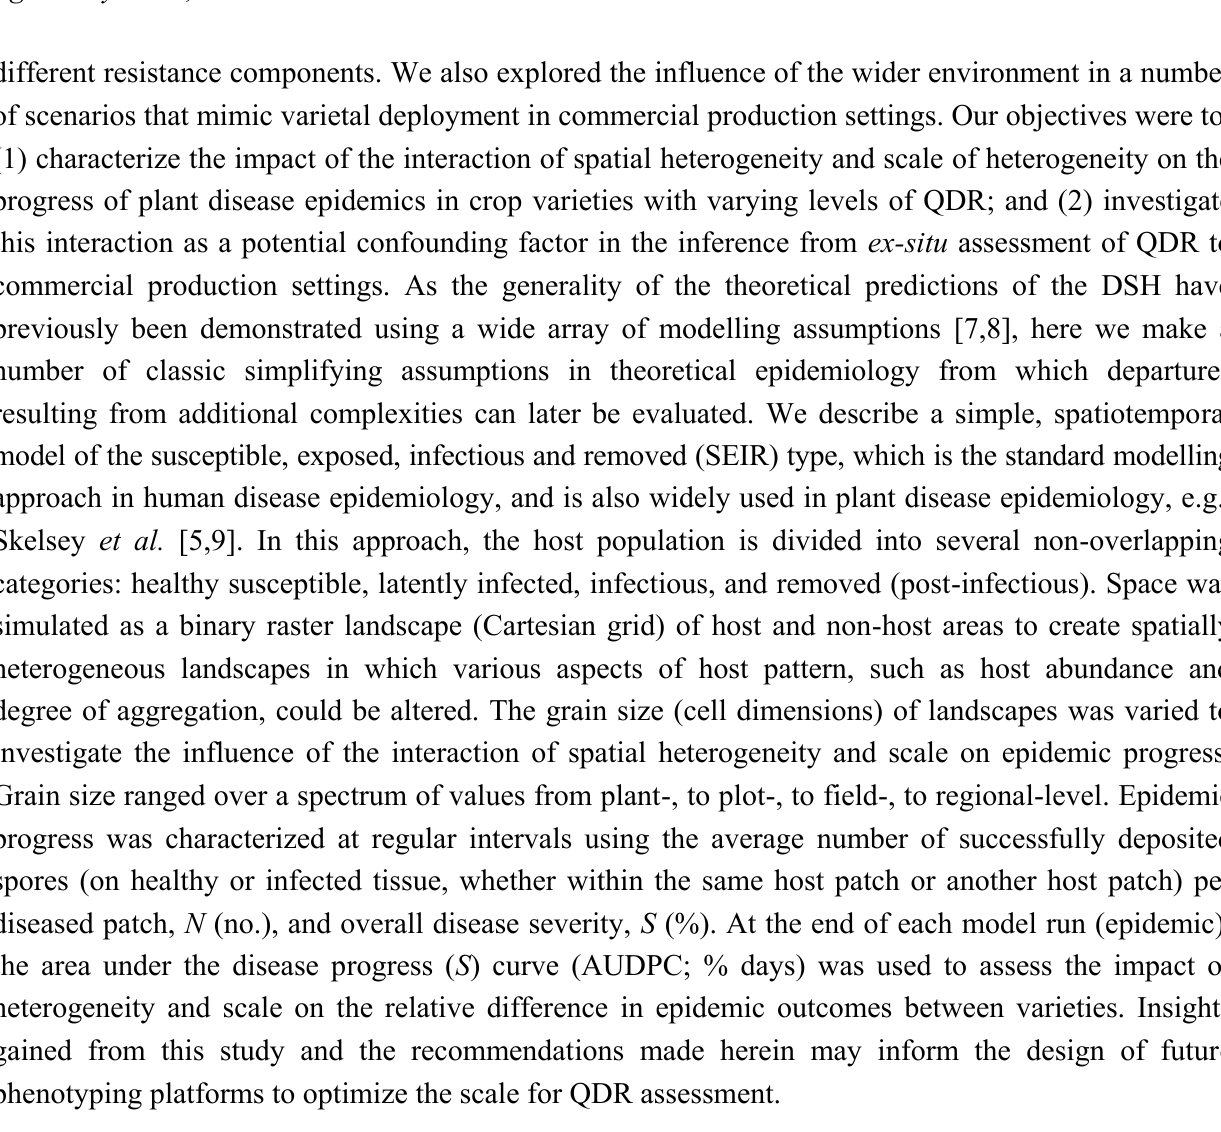
Figure 1. Conceptual diagram of the dispersal scaling hypothesis (DSH). Scaling